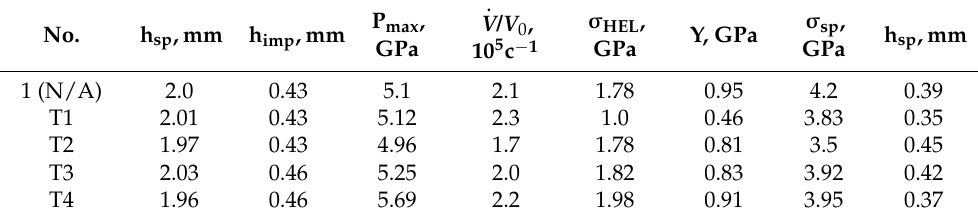
Figure 7. Hugoniot elastic limit, yield strength and spall strength of steel depending on heat treatment. Table 4. Experimental conditions and strength characteristics of steel.